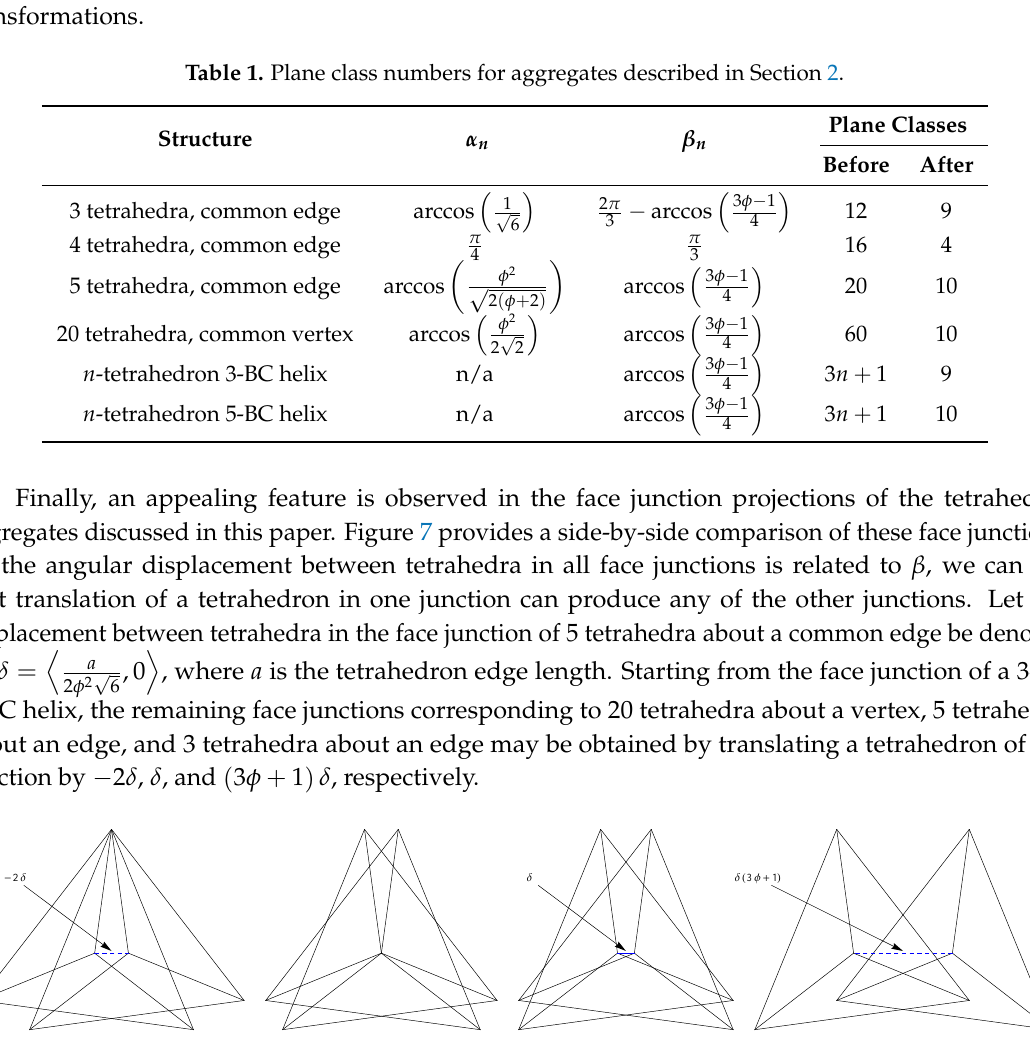
(cid:28) (cid:29) a √ ,0 , where a is the tetrahedron edge length, the 2 φ 2 6